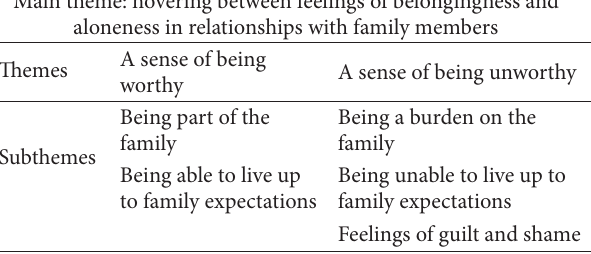
Table 1: Overview of the main theme, themes and